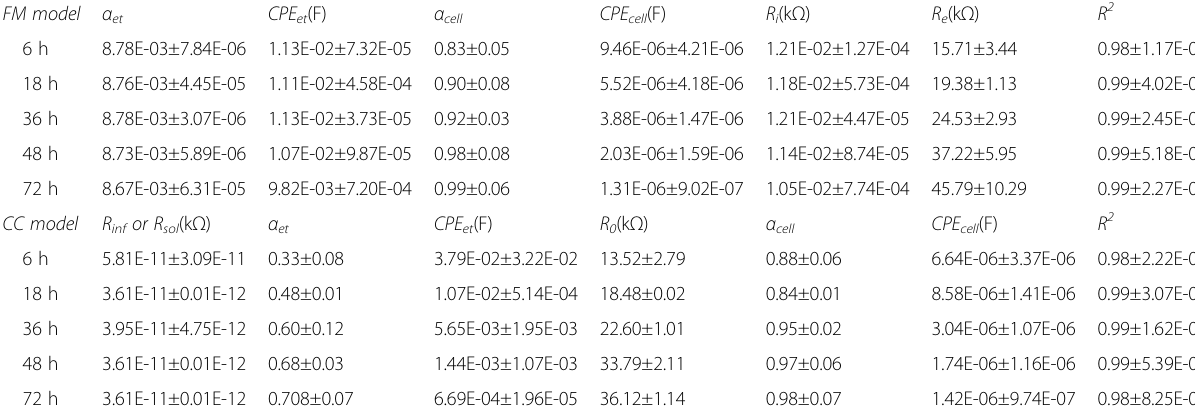
Table 1 Analytical values through an equivalent electrical circuit model of adherent cell-electrolyte-electrode system (fitting data derived from best of five developed microelectrode